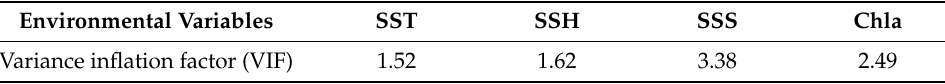
Table 2. Variance inflation factors (VIFs) of the environmental variables. Environmental